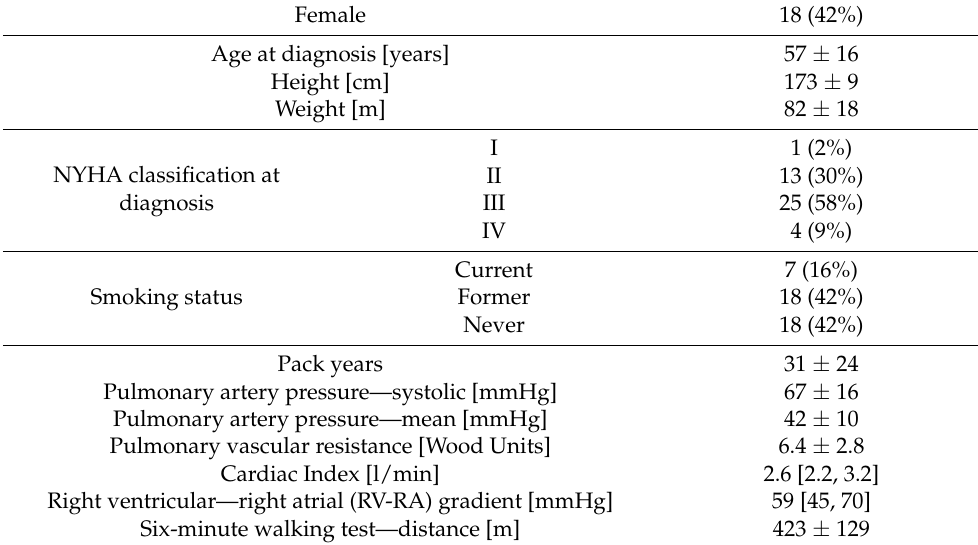
Table 1. Baseline demographics.